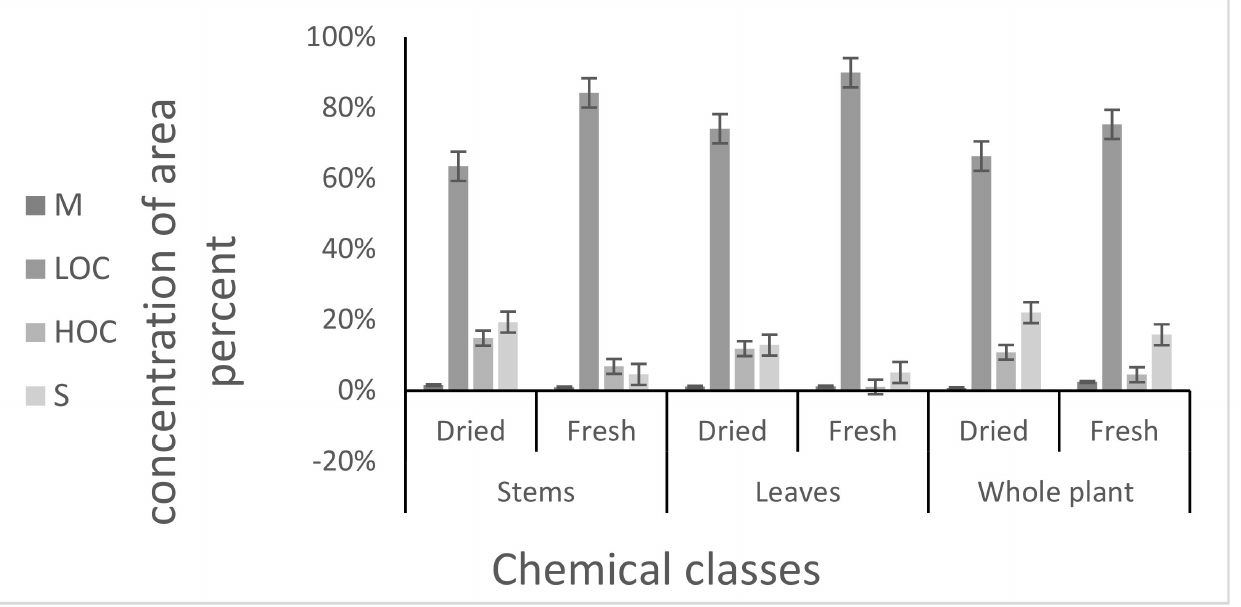
Figure 1. Drying effect on volatile oils constituents of M. suaveolens L. Sesquiterpenes (S), heavy oxygenated compounds (HOC), light oxygenated compounds (LOC), and monoterpenes (M).